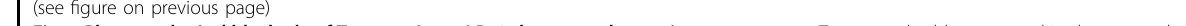
Fig. 7 Pharmacological blockade of Trem1 using mLR12 decreases the aortic rupture rate. a Trem1 was highly expressed in the macrophage subpopulation. b Schematic illustration of the treatment procedure. Two biological replicates ( n = 8 for each replicate) were performed for each group. All measurements were performed after 28 days of treatment. c Survival curves of mice treated with mLR12 or vehicle (saline solution). d Summary of the normal, TAAD, and rupture rates in each group. e mLR12 treatment could signi fi cantly decrease the aortic rupture rate. f Quanti fi cation of plasma levels of sTREM1. n = 6 for each group. g Quanti fi cation of the mRNA expression of Tnfa , Il1b , Il6 , Trem1 , and Cd11b in the aorta by qPCR ( n = 3). h Immuno fl uorescence staining for Cd11b + Trem1 + cells in mouse aorta of the mLR12 treatment group. i Immuno fl uorescence staining for Cd11b + Trem1 + cells in mouse aorta of the BAPN + vehicle group. j The percentage of the Cd11b + Trem1 + cells in each sample was calculated based on the immuno fl uorescence staining. Wilcoxon rank-sum test, P = 0.0004. n = 9 for each group. k Immuno fl uorescence staining for CD11b + TREM1 + cells in aortic adventitia of human TAAD patients. l Immuno fl uorescence staining for CD11b + TREM1 + cells in aortic adventitia of healthy donors. m The expression of TREM1 in aortic tissues of human TAAD patients ( n = 8) and healthy donors ( n = 6) measured by bulk RNA-seq. n The expression of TREM1 in CD11b + and CD11b − cells sorted from the aortic tissues of TAAD patients ( n = 4) measured by bulk RNA-seq. In f and g , all values are means ± SEM. * P < 0.05, ** P < 0.01, n.s. not signi fi cant, Kruskal – Wallis test followed by multiple pairwise comparisons between